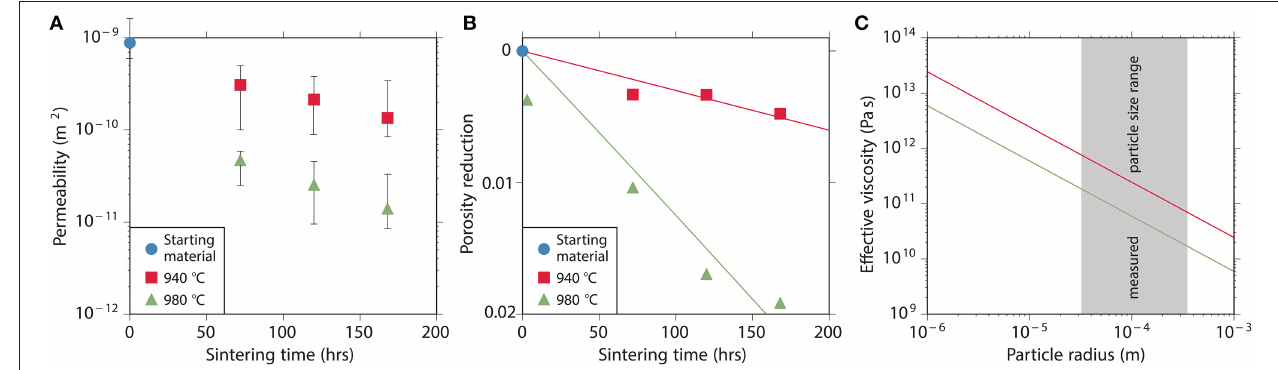
FIGURE 6 | Sintering dynamics: (A) Evolving permeability with sintering time at 940 and 980 ◦ C for the crushed andesite, (B) porosity change with sintering time for the same experiments, fitted with the neck formation model and at timescale τ (see Equation 2). (C) The co-varying viscosity and radius terms at 940 and 980 ◦ C used in τ to fit the neck-formation model (Frenkel, 1945) to the data in panel B , with the range of grain sizes used in the experiments marked. All data is presented in Table 3 . Error on permeability measurements is quoted by New England Research Inc. as < 0.2 orders of magnitude, while error on porosity is estimated to be < 0.1% for this sample size, doubled to a maximum error of 0.2% for porosity change, smaller than the symbols